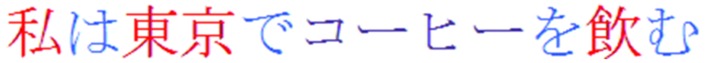
This Japanese sentence means “I drink coffee in Tokyo” and is pronounced “Watashi wa Tokyo de koohii o nomu.” The red graphs are written in kanji, the blue graphs are written in hiragana, and the purple graphs are written in katakana. The first kanji graph (red) means “I,” the second and third graphs mean “Tokyo,” and the fourth means “drink.” Note that the kanji characters are used for the content words. The first hiragana graph (blue) is a subject marker, the second is a location marker, the third is an object marker, and the fourth serves to conjugate the verb. The purple graphs mean coffee, pronounced “koohii,” a loan word from English.